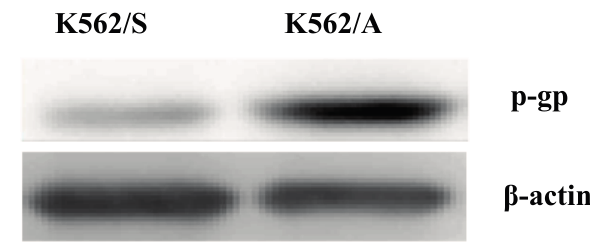
Figure 1. Expression of P-gp in K562 cells. Western blotting analysis of P-gp expression in K562/A cells and K562/S